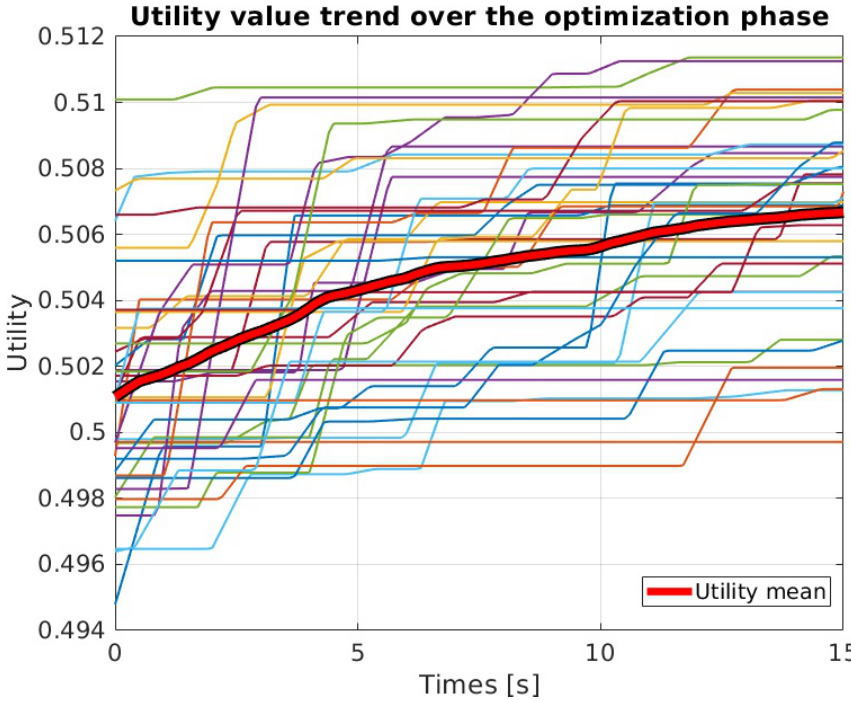
Figure 11. Utility value trend over the optimisation phase of the GPP algorithm. ( a ) Area 1; ( b ) Area 2; ( c ) Area